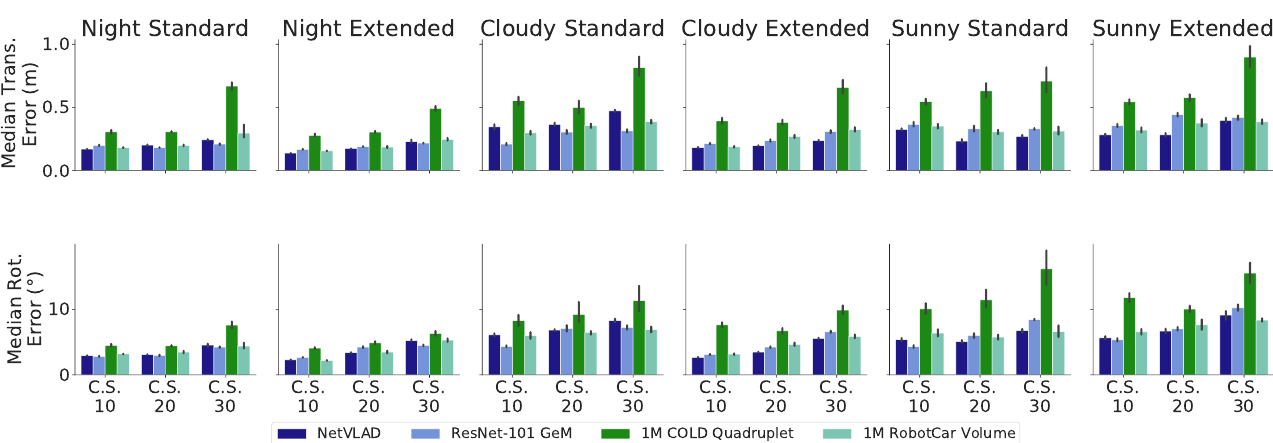
Figure 6. Comparison of the median translational and rotational errors of our proposal in the COLD-Freiburg dataset, tested at every sequence and with different Constant Sampling (CS) rates, using each holistic descriptors with 10 3 particles. Note that the maps were constructed employing sequences under similar conditions to the night sequences. This is better seen in